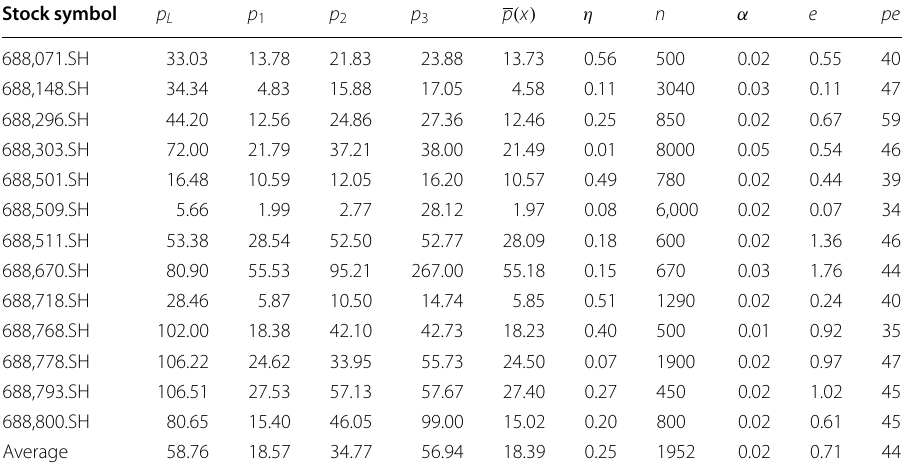
Table 6 Data of selected stocks relevant to quotation process Stock